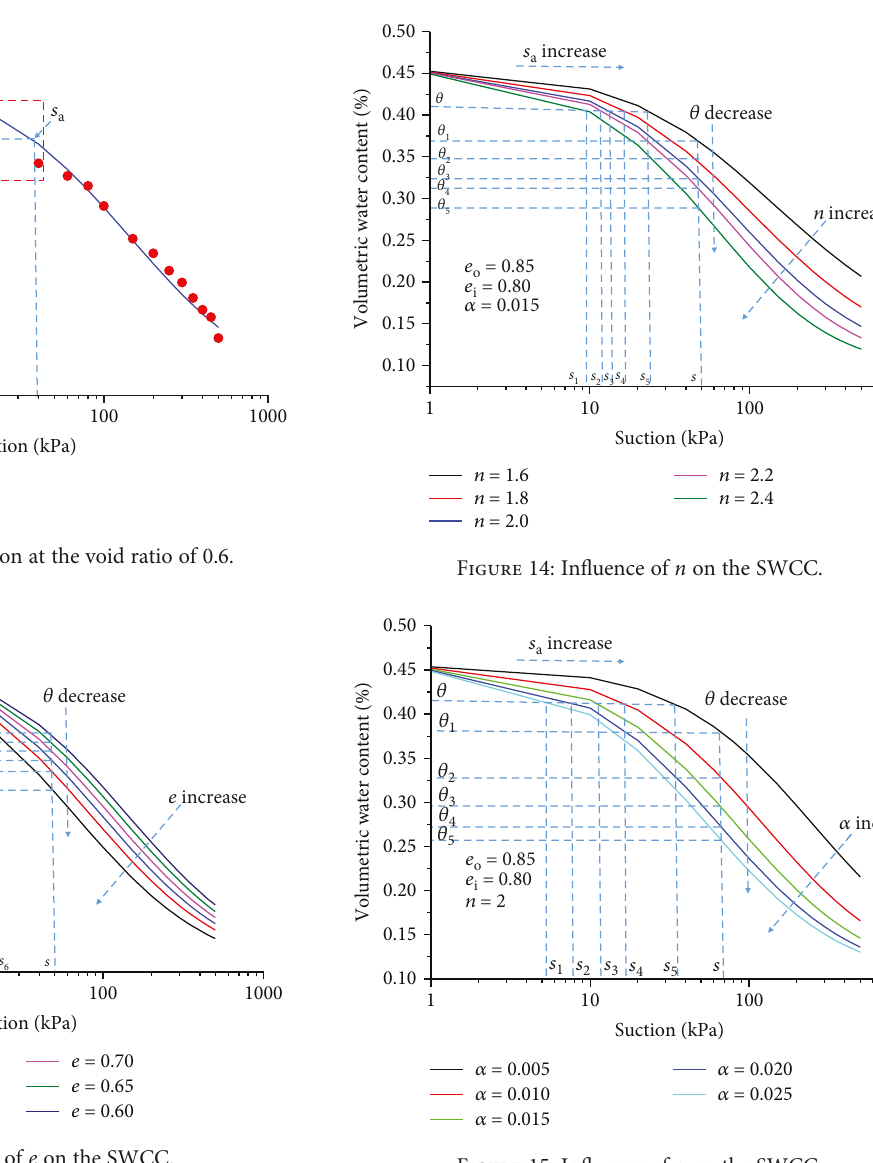
Figure 15: In fl uence of α on the